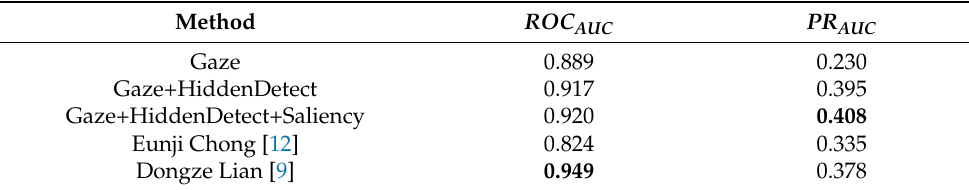
Figure 6. Application of the robot in autism rehabilitation training. Figure 7. Illustration of cross-frame gaze estimation. 3.3. Object Description Evaluation To assess the performance of our proposed method, we compared it with that of other state-of-the-art methods. Reference [30] proposes an adaptive attention algorithm, [21] combines object detection with image caption to achieve improved performance, and [31] combines object detection with an adaptive attention algorithm to obtain more specific descriptions. The dataset is collected from the perspective of a robot.